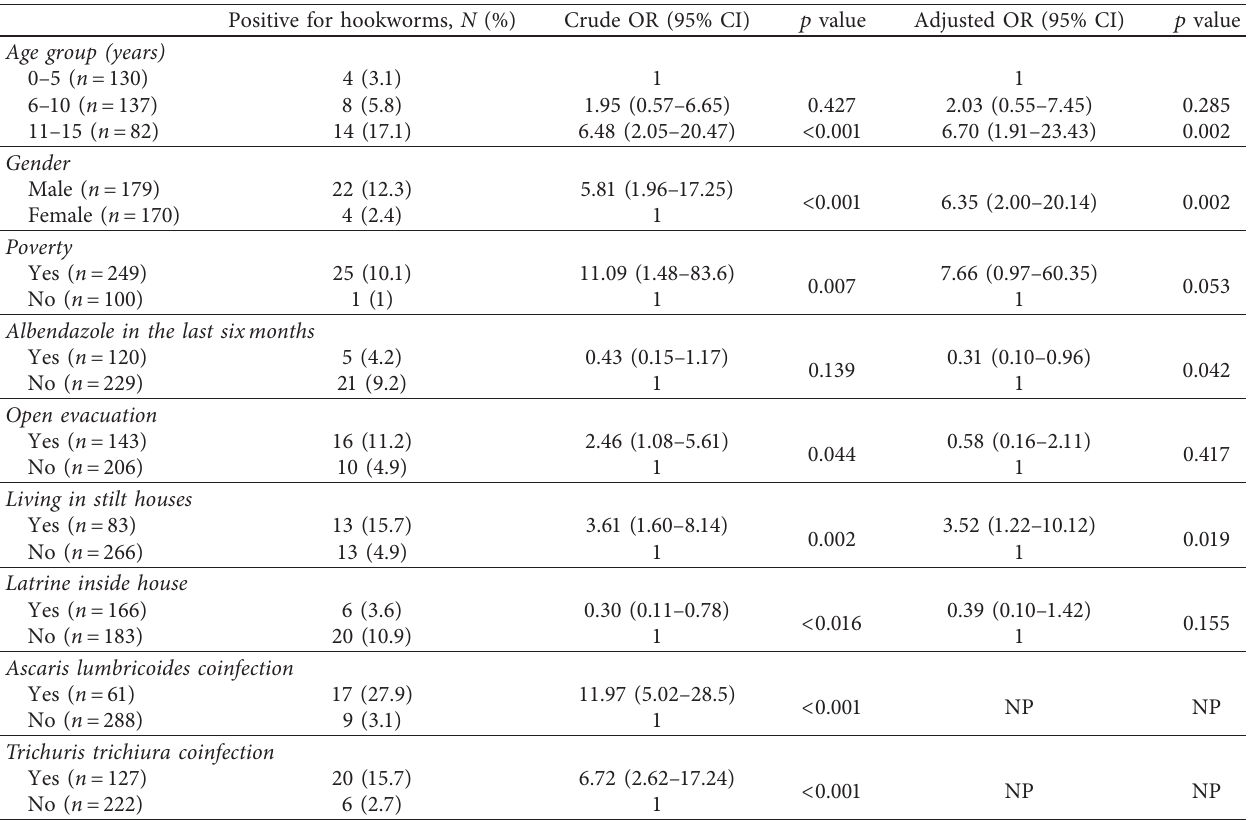
Table 3: Factors associated with hookworm infection in children living in the urban area of Bagre, Par´a State, Brazilian